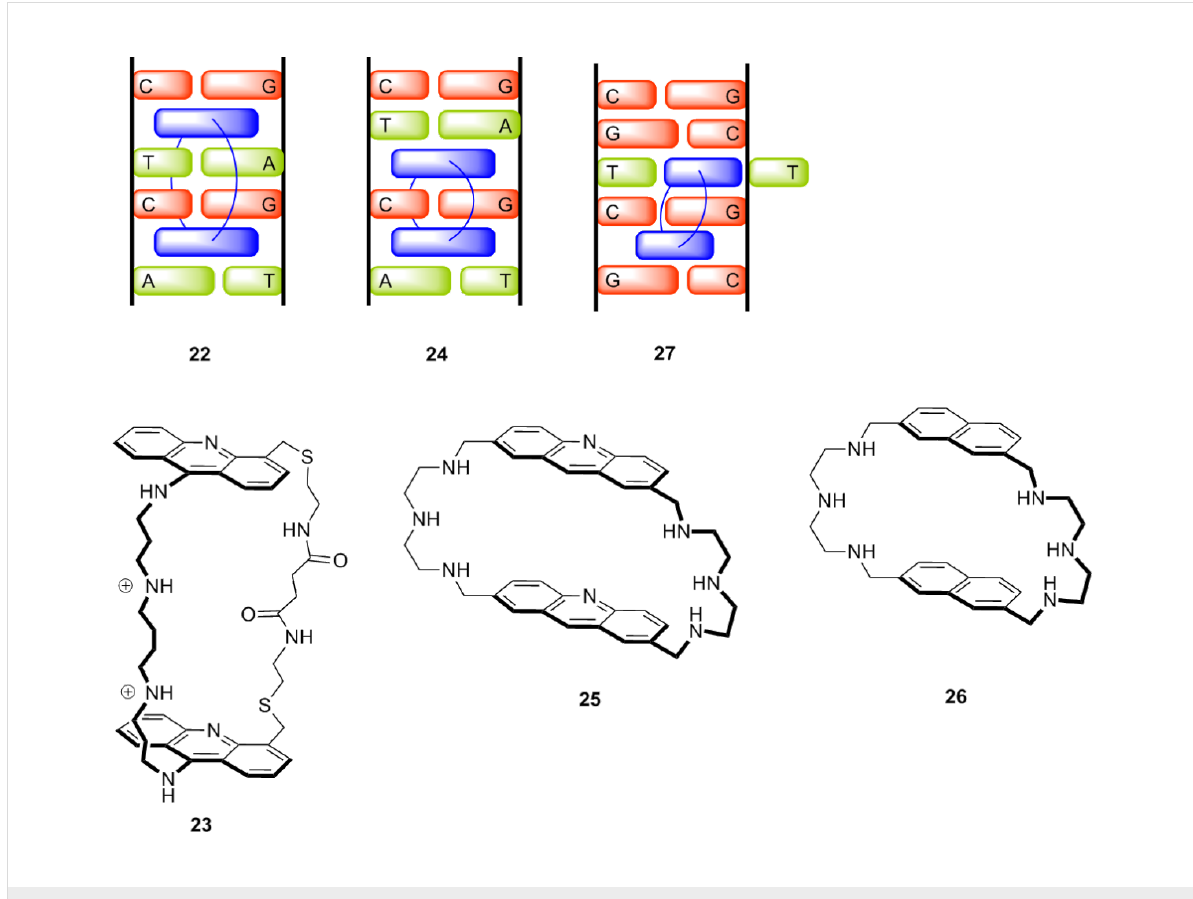
Figure 7: Macrocyclic diacridines and dinaphthalene and the intercalation complexes they may form with one chain in each groove.